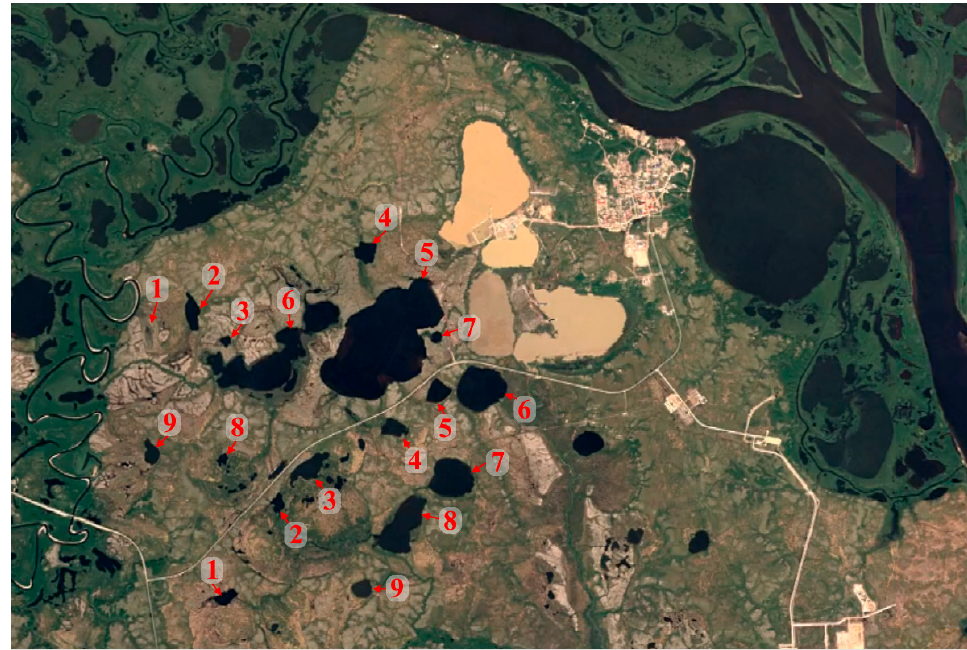
Figure 5. The village of Gaz-Sale and the study area showing the lakes in 2019 that can be com- pared with the lakes in 2014 (Figure 2b). Note the disappearing lake UA1 and the change in the water color of the disturbed lakes.